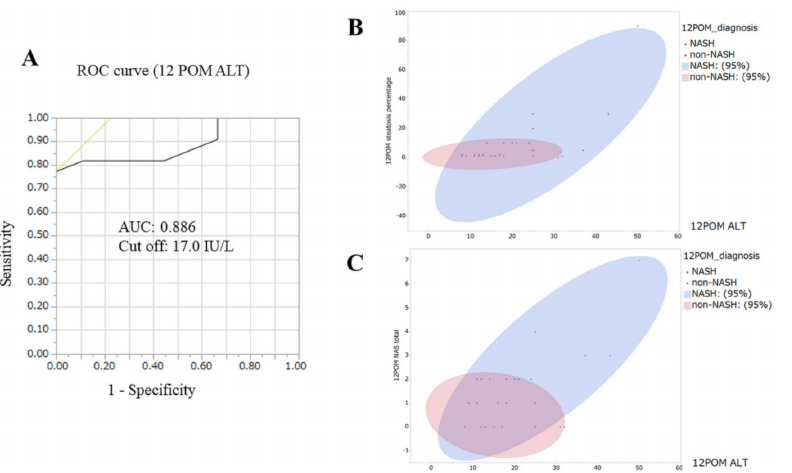
Figure 10. ( A ) The ROC curve revealed the cut-off and AUC of ALT. ( B ) Scatter plots between steatosis and L/S ratio. Almost all red plots (non-NASH) were in both lower ALT level and lower steatosis percentage locations at 12 months after LSG. ( C ) Almost all red plots (non-NASH) were in low NAFLD activity score locations with lower ALT